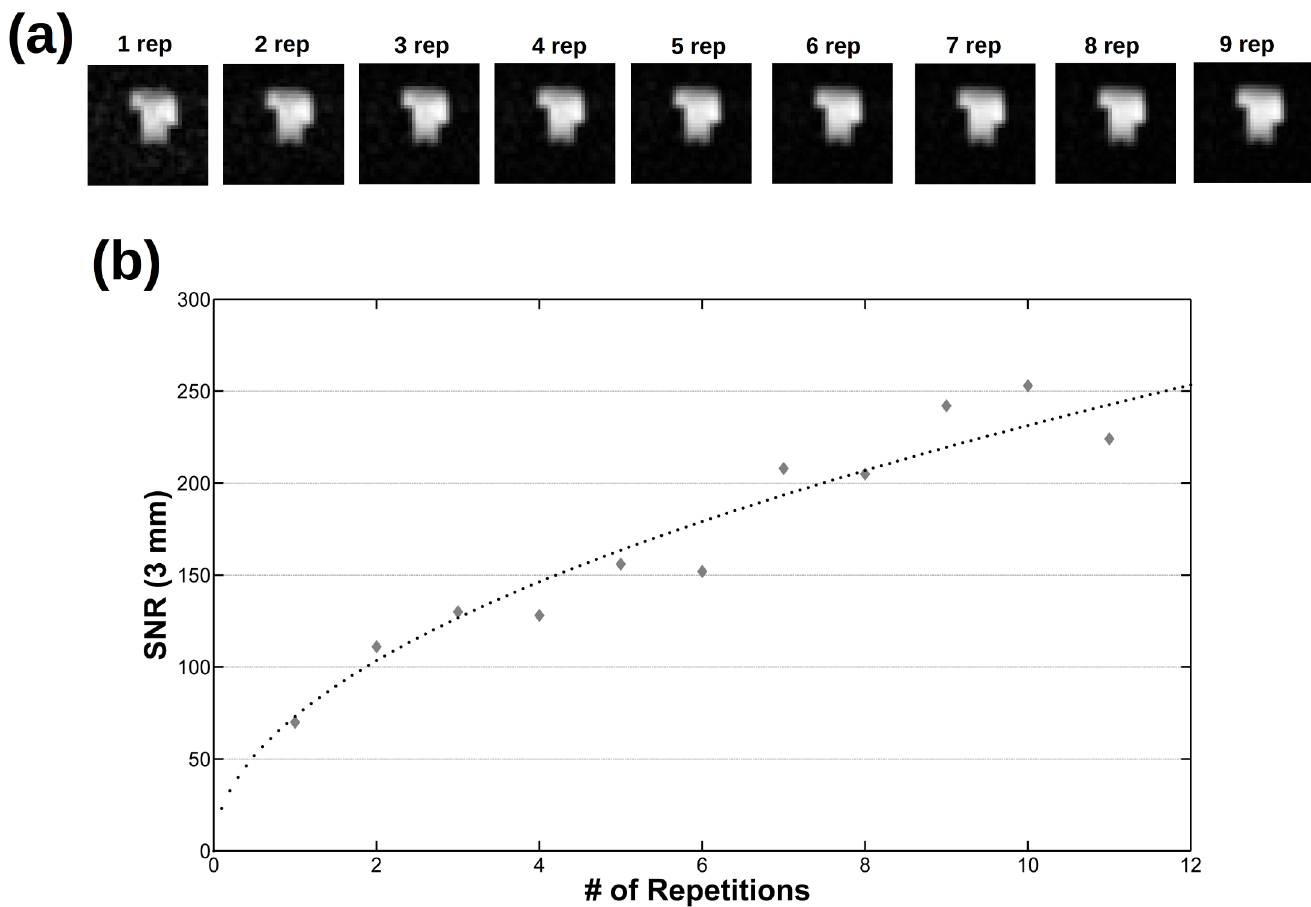
Fig 8. Behaviour of the SNR as a function of NEX. Same acquisition as in Fig 7: the same slice at different NEX values (a) and the corresponding measured SNR (b), together with the related const (cid:4)